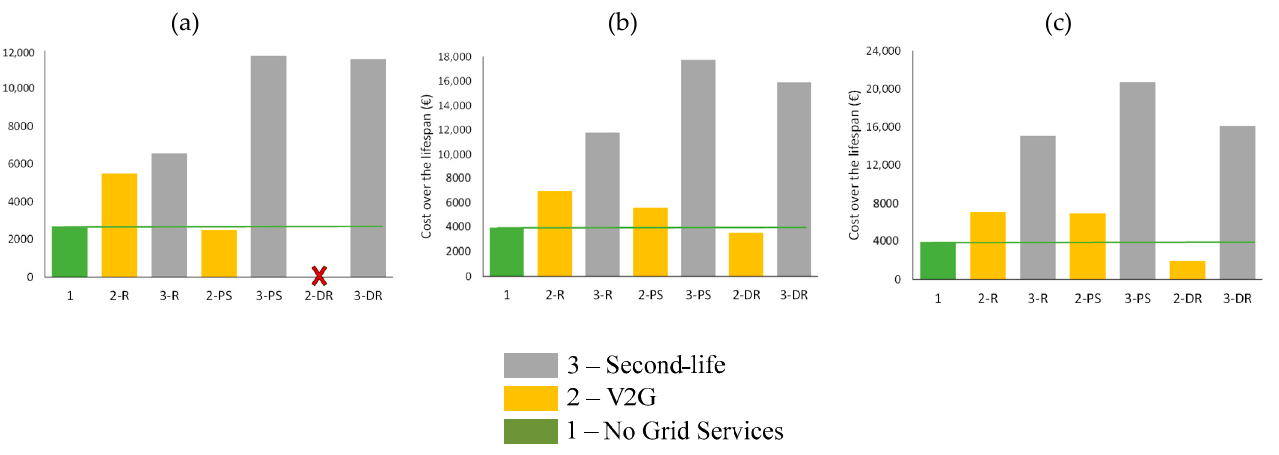
Figure 6. Cost over the battery lifetime for ( a ) 40 kWh batteries, ( b ) 70 kWh batteries, and ( c ) 90 kWh batteries.